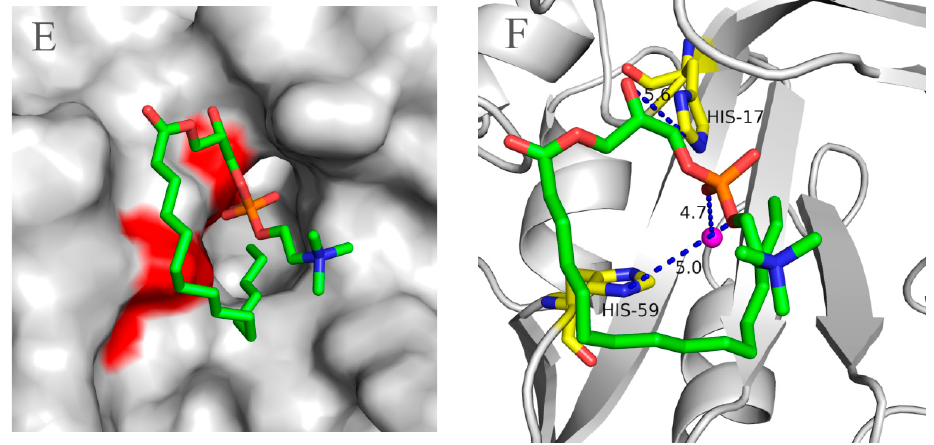
Figure 9. The 3D structures of the pfGDPD-phospholipid complexes. ( A ) surface view of the most suitable binding position and orientation of GPC. Two catalytic histidine residues are shown in red; ( B ) a close-up view showing the distance between the GPC and two histidine residues as well as the bivalent cation (shown in magenta). The hydrogen bonds formed with related residues (in the black pane); ( C ) surface view of the most suitable binding position and orientation of 1-LPC. Two catalytic histidine residues are shown in red; ( D ) a close-up view showing the distance between the 1-LPC and catalytic two histidine residues as well as the bivalent cation (shown in magenta ) by dashed line in blue. The hydrogen bonds formed with related residues aremarked by dashed line in orange; ( E ) surface view of the most suitable binding position and orientation of 2-LPC. Two catalytic histidine residues are shown in red; ( F ) A close-up view showing the distance between the 2-LPC and catalytic two histidine residues as well as the bivalent cation (shown in magenta ) by dashed line in blue.